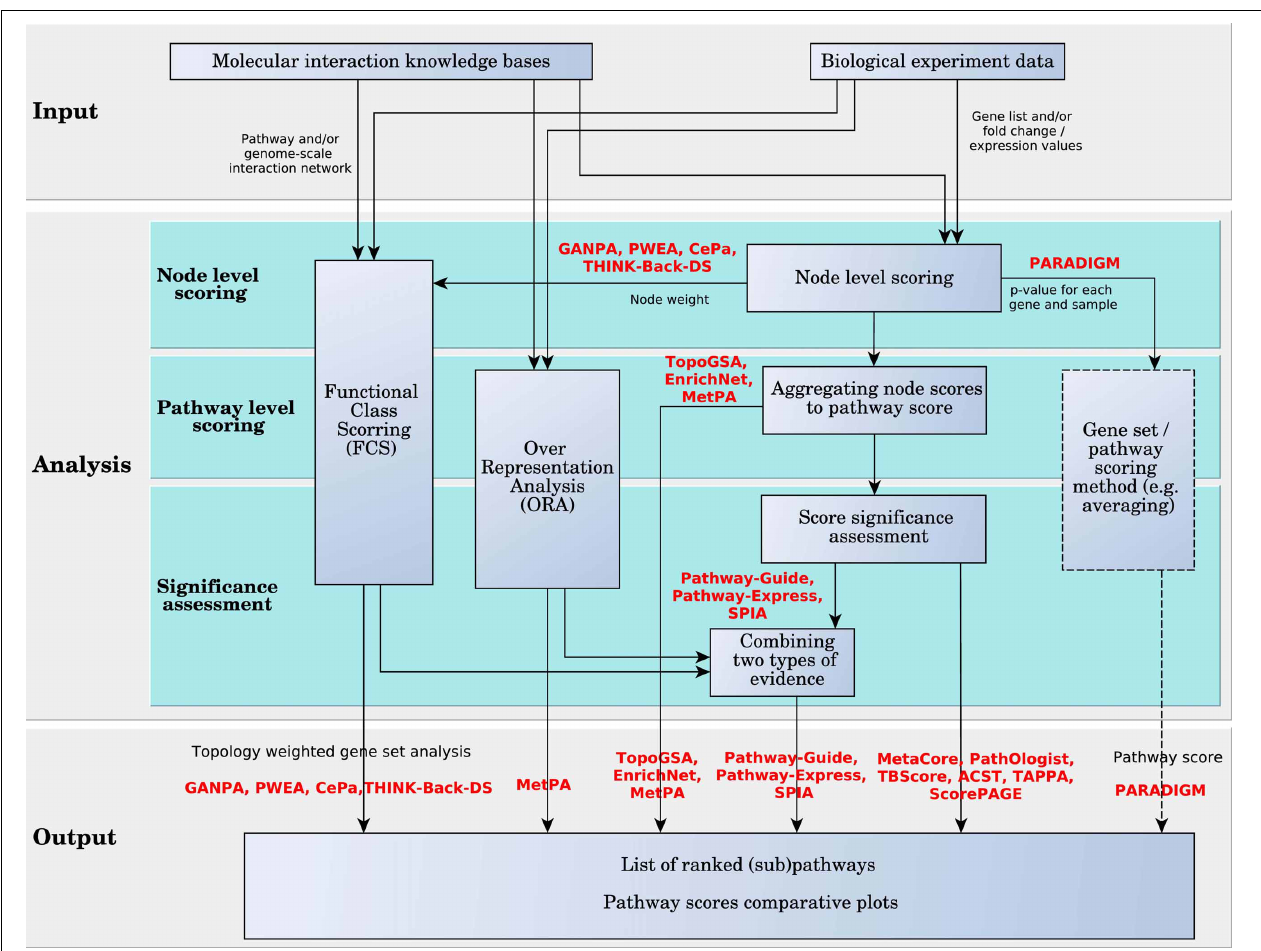
FIGURE 7 | Diagram of pathway analysis scoring approach for hierarchically aggregated scoring algorithms. The box with the dashed border indicates that the user can choose these options, but are not offered by the method